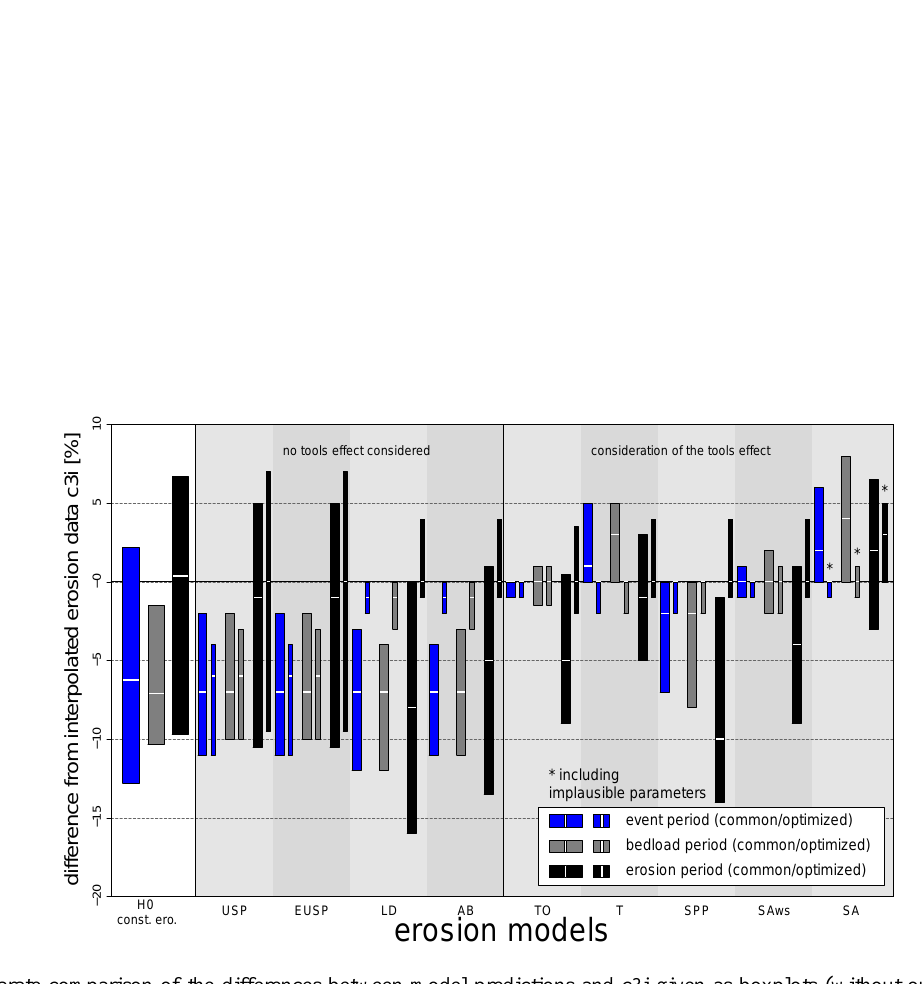
Figure B2. Separate comparison of the differences between model predictions and c3i given as boxplots (without outliers). Each model performance is shown for the three different periods of consideration (the same colors as the time periods indicated in Figs. 1 and 2) with runs using both common and optimized parameter sets (wide and narrow boxes) for each